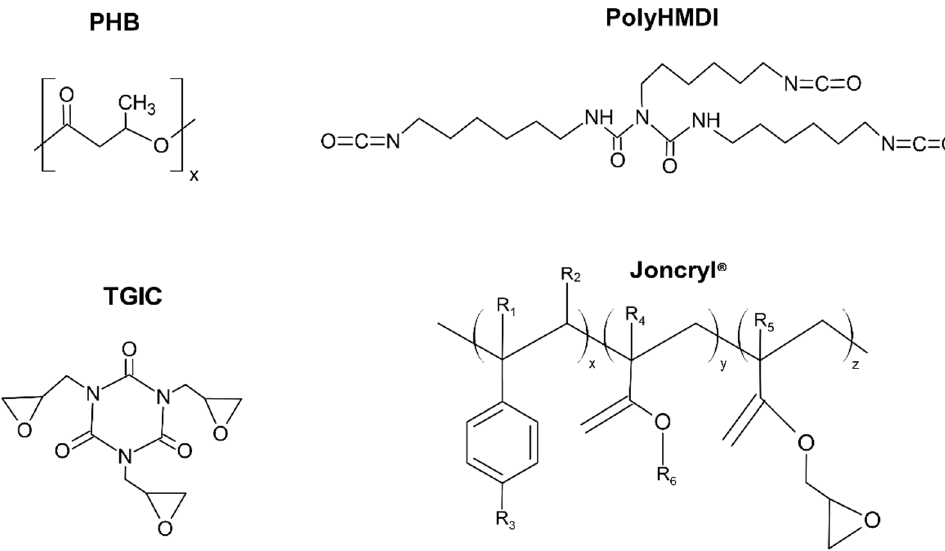
Figure 1. Chemical structures of materials used in this